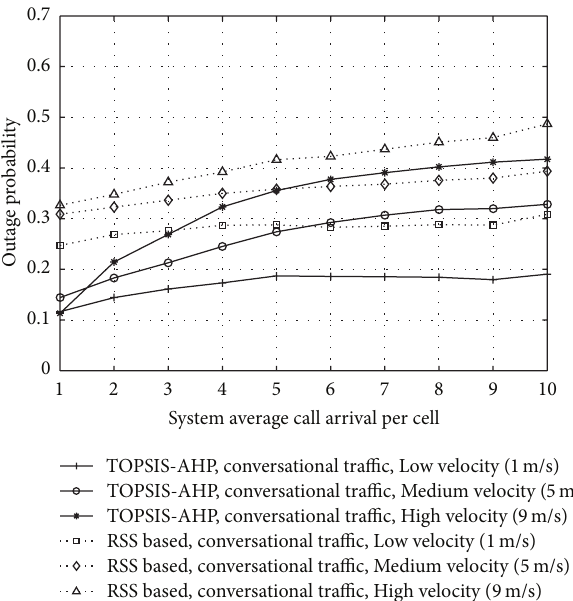
Figure 5: Outage probability using TOSPSIS-AHP.